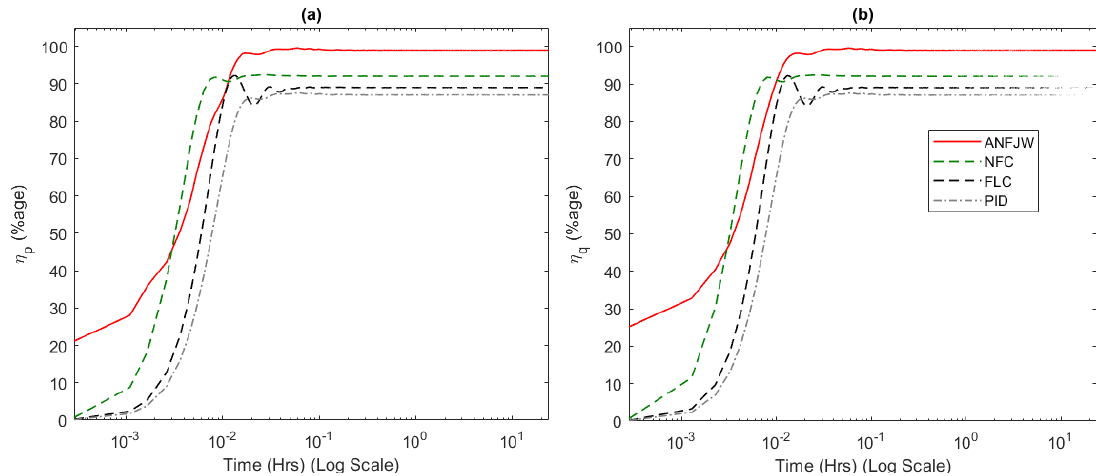
Figure 17. Power efficiency comparison of different controllers: ( a ) real power and ( b ) reactive power. Figure 17. Power e ffi ciency comparison of di ff erent controllers: ( a ) real power and ( b ) reactive